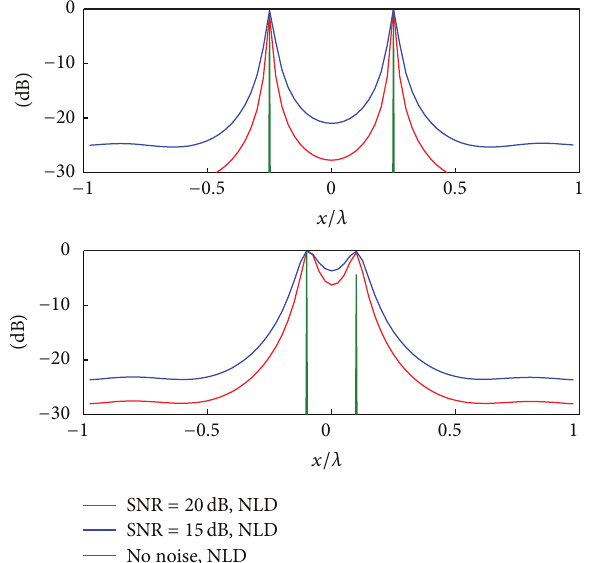
Figure 9: Analysing two-point resolution for TRM. Cut view along the 𝑥 -axis of the normalised TRM pseudospectrum.